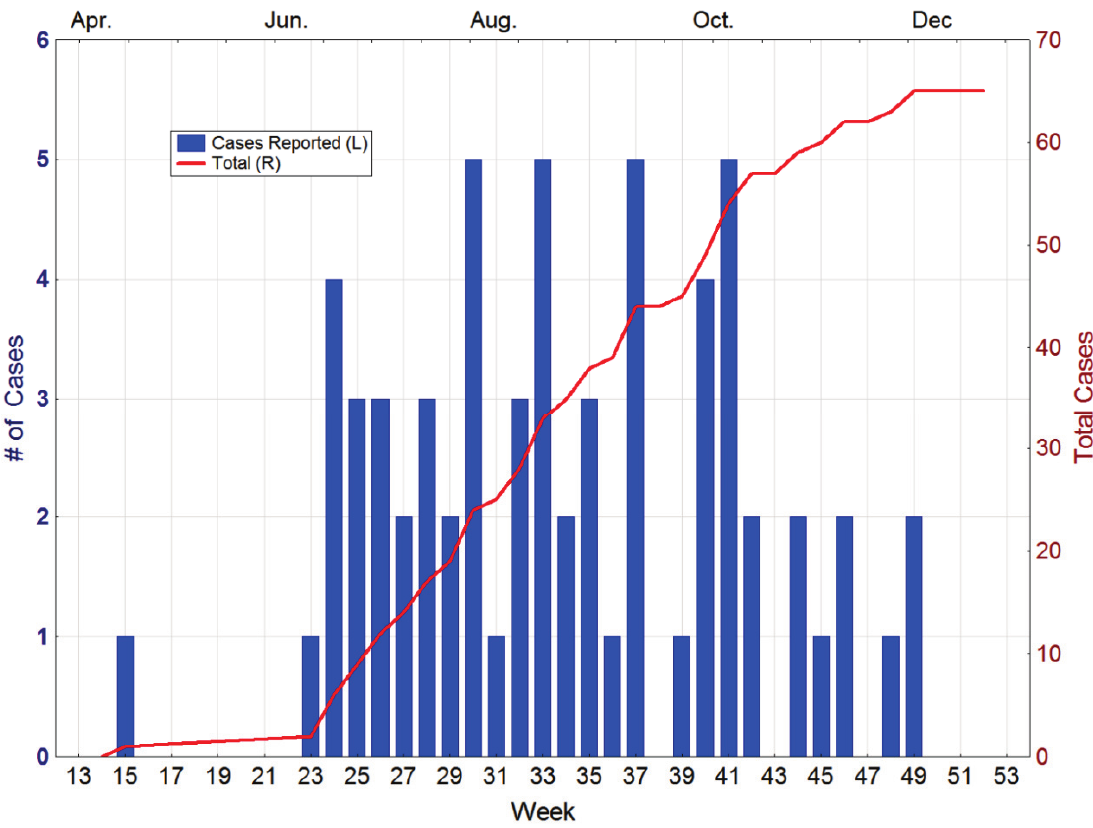
Figure 3. Dengue cases reported from Key West in 2010. Source Florida Department of Health